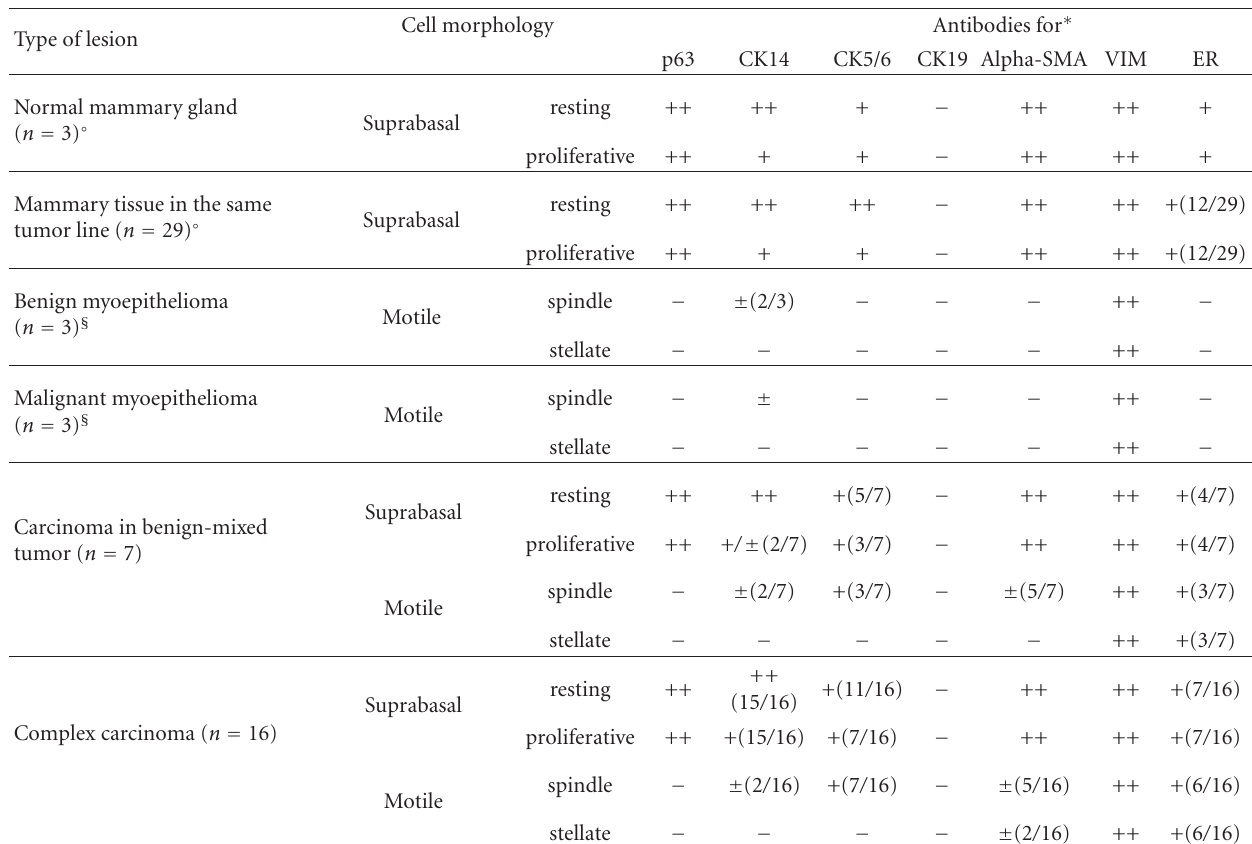
Table 2: Immunohistochemical results for suprabasal and motile myoepithelial